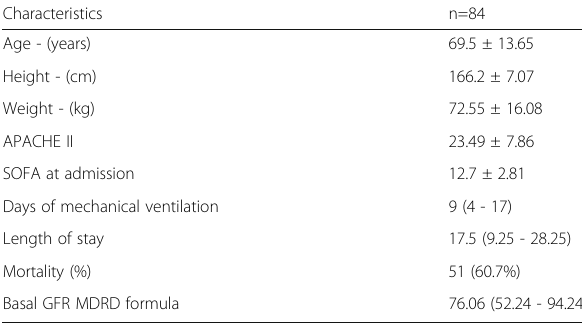
Fig. 1 (abstract 0164). Analysis of 126 urine samples collected from 42